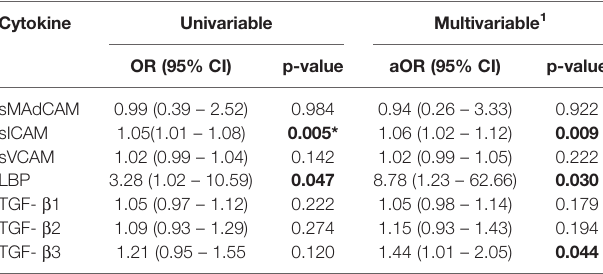
TABLE 1 | Univariable and multivariable analysis of TRuTH plasma analytes (sMAdCAM, sICAM, sVCAM, LBP, TGF- b 1, TGF- b 2 and TGF- b 3) as biomarkers of TB recurrence.